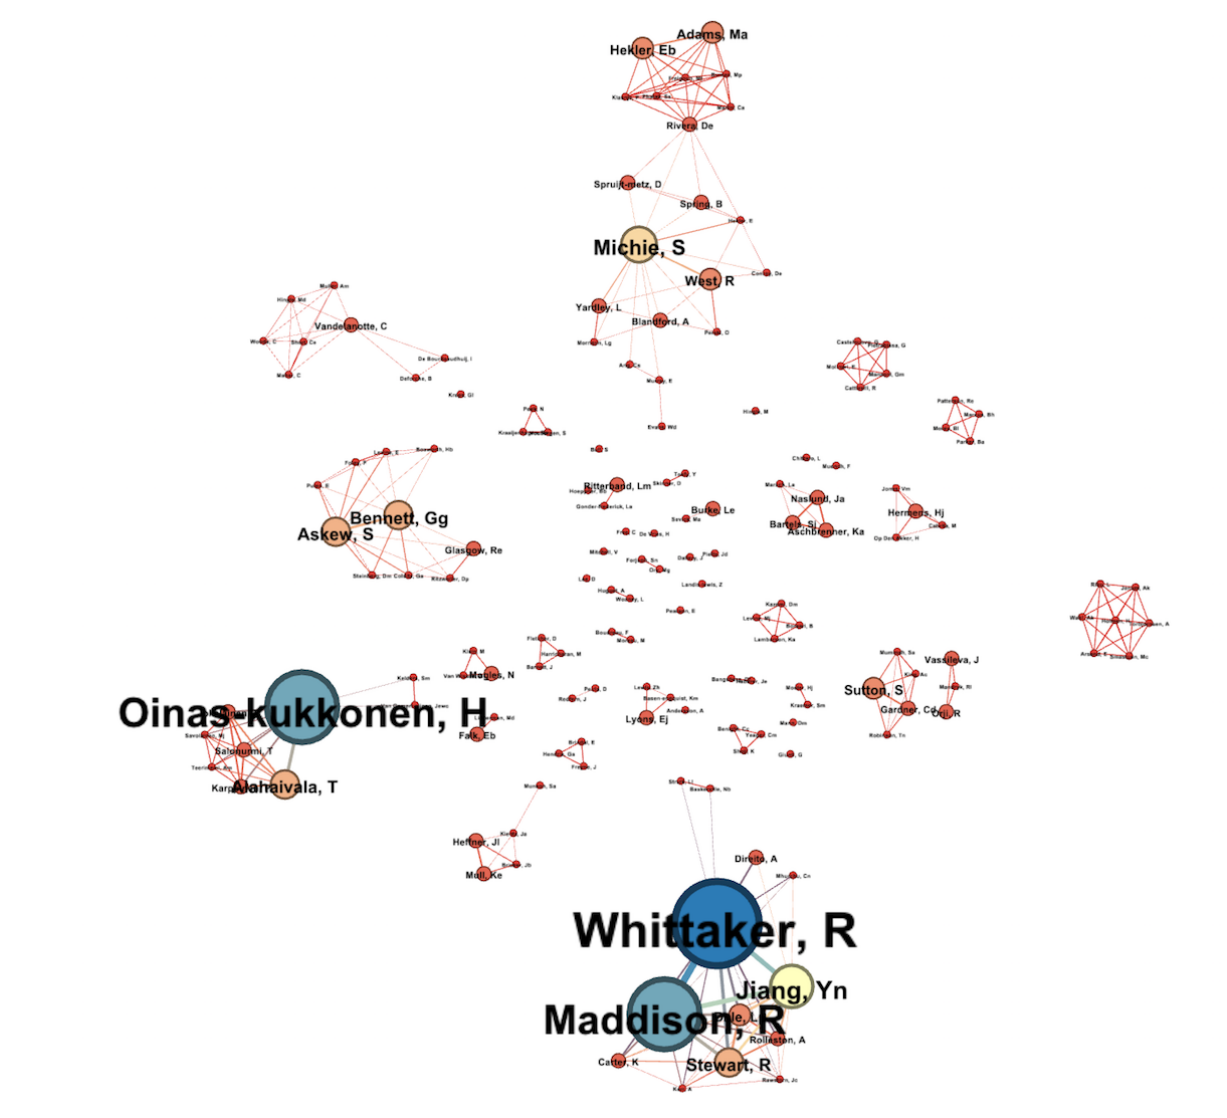
Figure 5. Coauthor